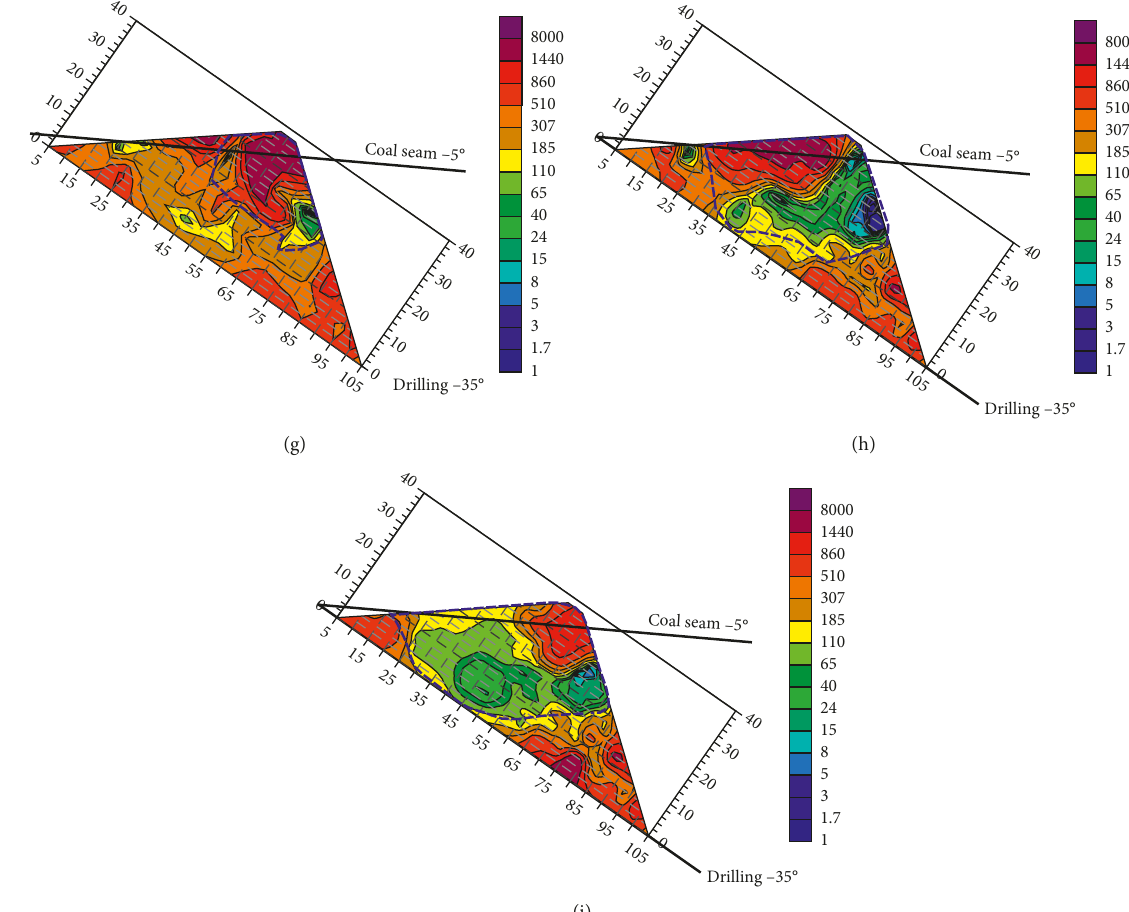
Figure 12: Resistivity results for borehole #1 at different locations on the working face: (a) 814m, (b) 807m, (c) 802m, (d) 796m, (e) 793m, (f) 783m, (g) 762m, (h) 682m, and (i)